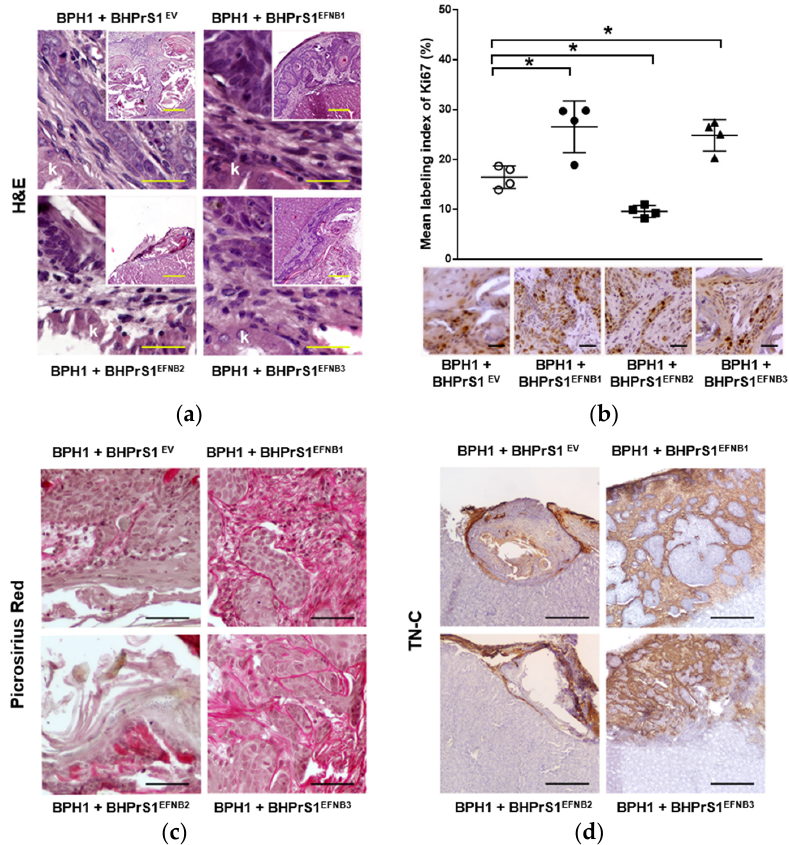
Figure 5. Increased stromal EFNB1 and EFNB3 is associated with enhanced proliferation of BPH1 cells and stromal remodeling in vivo . ( a ) Hematoxylin and eosin (H&E) stained sections of the tu- mors resulting from grafts of BPH1 with engineered BHPrS1 cell lines. Grafts of BPH1 with BHPrS1 EFNB1 and BHPrS1 EFNB3 show pronounced inflammatory infiltrates compared to BHPrS1 EV . ( b ) Immunohistochemical (IHC) staining showing pronounced Ki67 expression in BPH1 tumors with BHPrS1 EFNB1 and BHPrS1 EFNB3 and reduced Ki67 expression in BHPrS1 EFNB2 compared to BHPrS1 EV . Dot plot showing Ki67 expression quantification (* p < 0.05, one-way ANOVA). ( c ) Higher collagen deposition in BPH1 tumor grafts with BHPrS1 EFNB1 and BHPrS1 EFNB3 compared to BHPrS1 EV as shown by picrosirius red staining. ( d ) ECM remodeling marker Tenascin-C (TN-C) is highly ex- pressed in tumor grafts of BPH1 with BHPrS1 EFNB1 and BHPrS1 EFNB3 compared to BHPrS1 EV . Grafts of BPH1 with BHPrS1 EFNB2 and BHPrS1 EV has relatively lower expressions of TN-C. k in the figure represent Kidney. Scale bars in yellow and black lines in the figures represent that pictures were taken at the same magnification. 3.7. EFNB1 and EFNB3 Activate SFK in Prostate Fibroblasts To investigate downstream signaling of EFNB ligands overexpression in BHPrS1 cells, we quantified the expression of a panel of phospho-kinases using an antibody-based array in BHPrS1 EV , BHPrS1 EFNB1 , BHPrS1 EFNB2 , and BHPrS1 EFNB3 cells. Quantitation of the intensity demonstrated that phosphorylation signals were differentially activated in each of the EFNB-expressing cell lines compared to BHPrS1 EV (Figures 6a and S4). Notably, overexpression of EFNB ligands exhibited changes in tyrosine phosphorylation of several members of the Src family kinases (SFKs) including Src, Lck, Lyn, and Yes (Figure 6a,b) compared to BHPrS1 EV . BHPrS1 EFNB1 showed high phosphorylation in Src family kinases Lck (Y394), Lyn (Y397), Yes (Y426), and Src (Y419) (Figure 6b) compared to BHPrS1 EV . In contrast, BHPrS1 EFNB2 displayed significantly lower amounts of phosphorylation in SFKs compared to BHPrS1 EV . Among all the SFKs, BHPrS1 EFNB3 had significantly higher phos- phorylation of only Lck and Lyn at Y394 and Y397 sites (Figure 6b). These results show that SFK phosphorylation can be activated (in EFNB1 and EFNB3) or suppressed (EFNB2) by EFNB ligands in prostate fibroblasts. Others have shown the potential role of SFKs in the activation of fibroblasts in different organs and their promotion of fibrosis [43–46]. Next, we studied whether SFK phosphorylation is required for EFNB-induced CAF acti- vation.